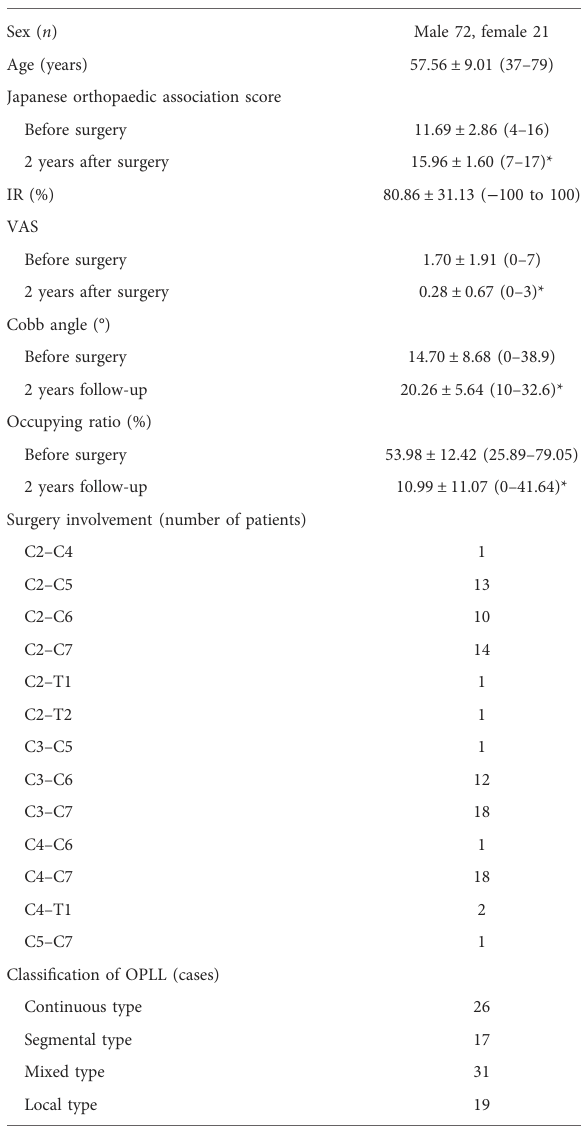
TABLE 1 Clinical preoperative and postoperative data of the patients.